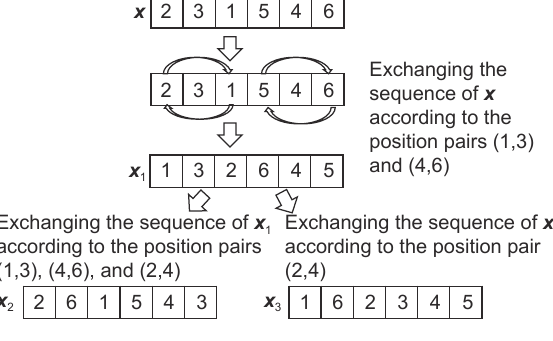
Fig. 3 Influence of the exchange